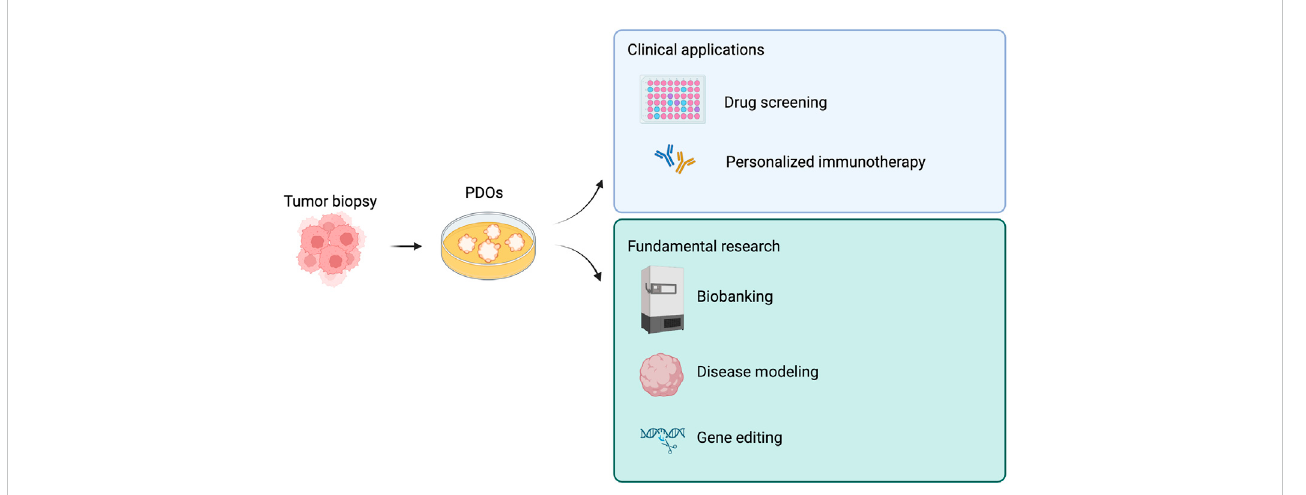
FIGURE 3 Derivations and potential applications of patient-derived tumor organoids (PDOs). PDOs can be used in the clinic as a drug screening platform and to guide personalized immunotherapy. Similarly, PDOs are a useful tool for fundamental research. Created with BioRender.com.